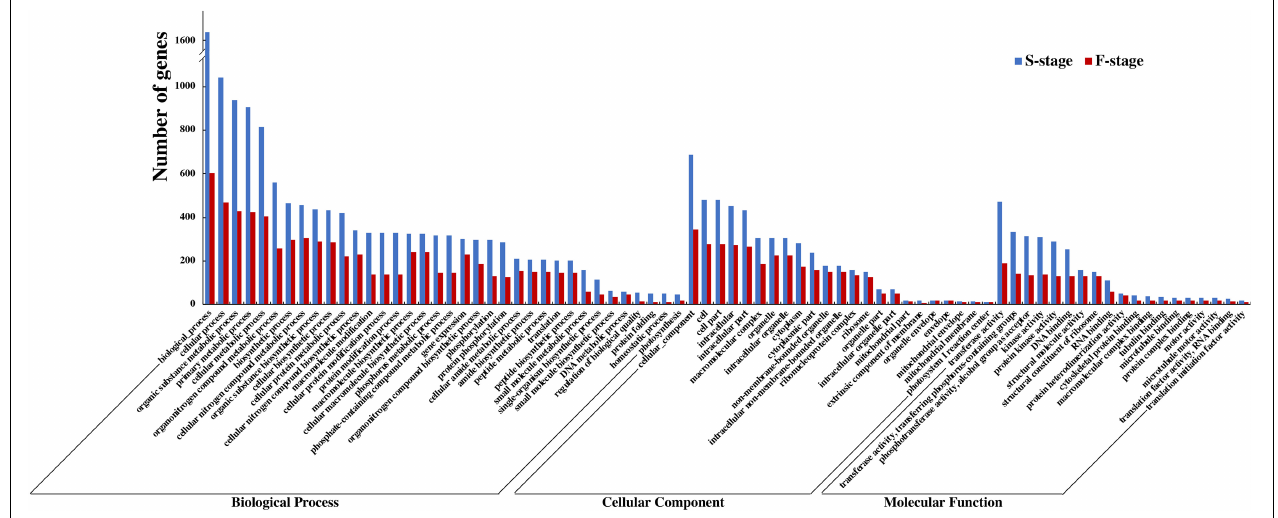
FIGURE 3 | Comparison of Gene Ontology (GO) classification of differentially expressed genes (DEGs) at the seedling and flowering stages.